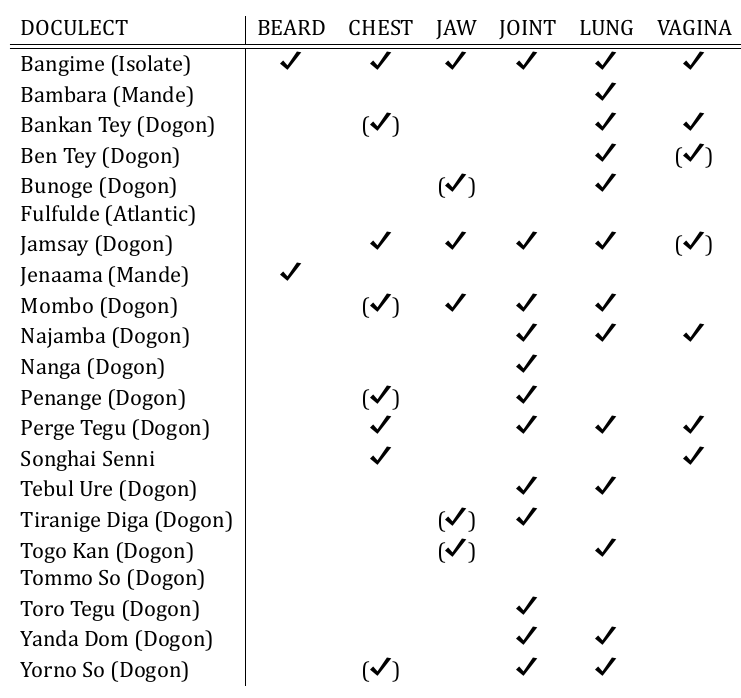
Table 6: Shared body parts in the